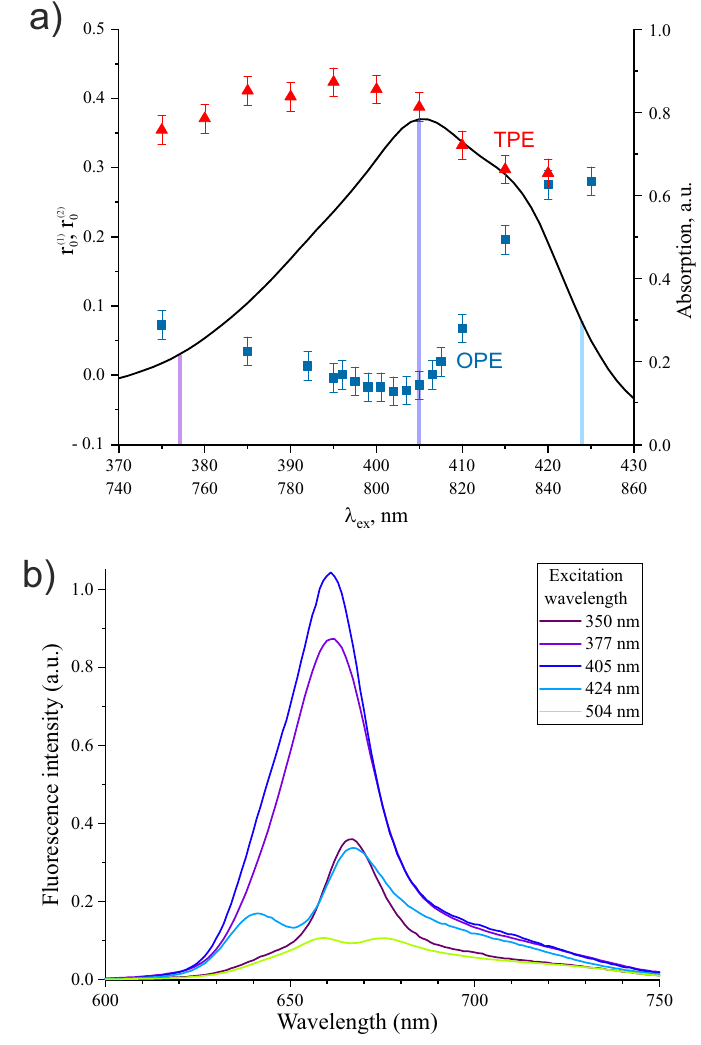
( 1 ) ( 2 ) and r of Radachlorin in 40% MeOH as a function 0 0